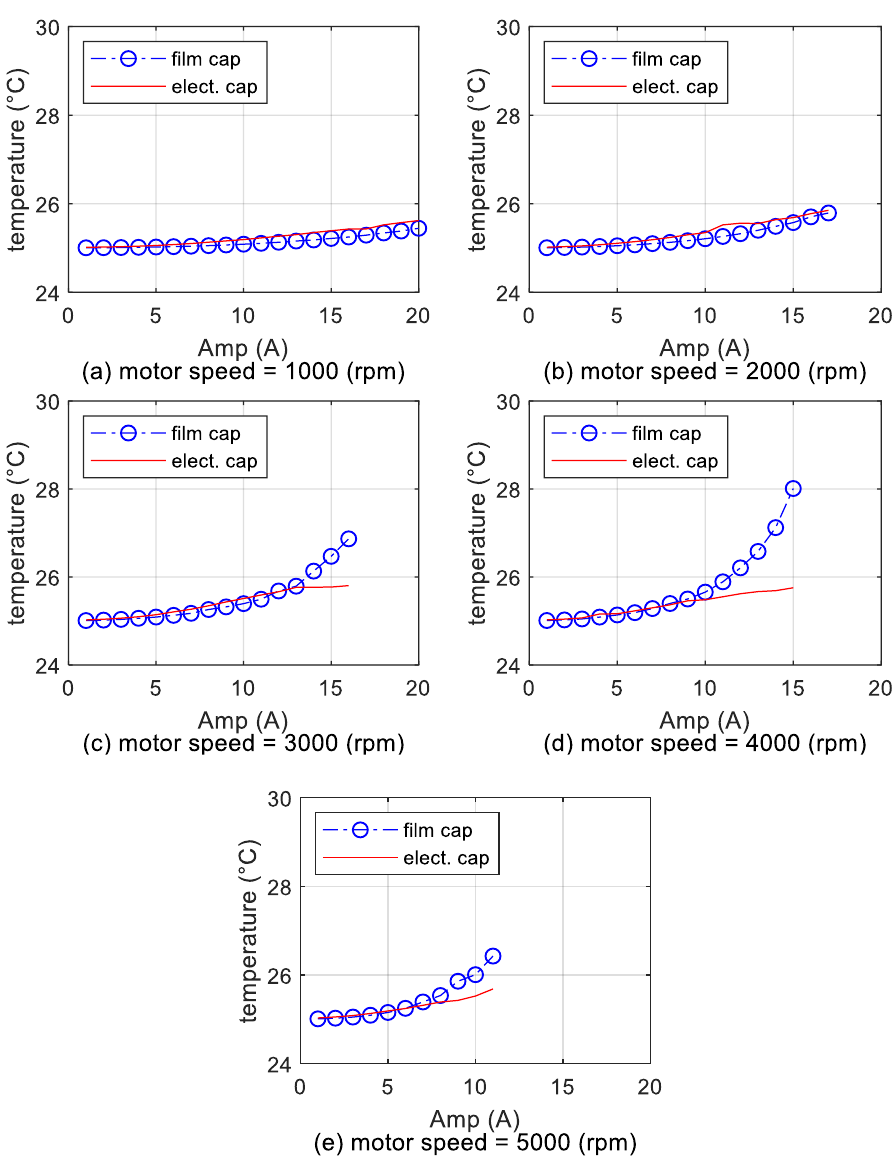
Figure 24. Heat generation by the electrolytic and film capacitor as functions of the motor current.